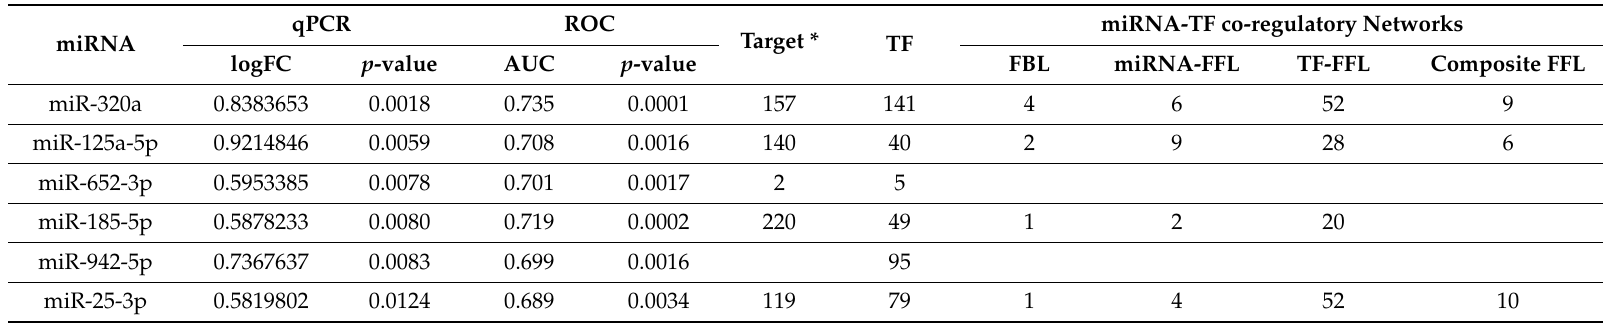
Table 2. List of significantly upregulated miRNAs in the comparison between MS and HC. For each miRNA, the log2 fold change and p -value from qPCR analysis have been detailed. The ROC section shows the results of AUC and associated p -value. The total number of miRNA targets and TFs that regulate each miRNA has been indicated. In the last section (miRNA-TF co-regulatory networks), we listed the total number of networks in which the studied miRNAs seem to be